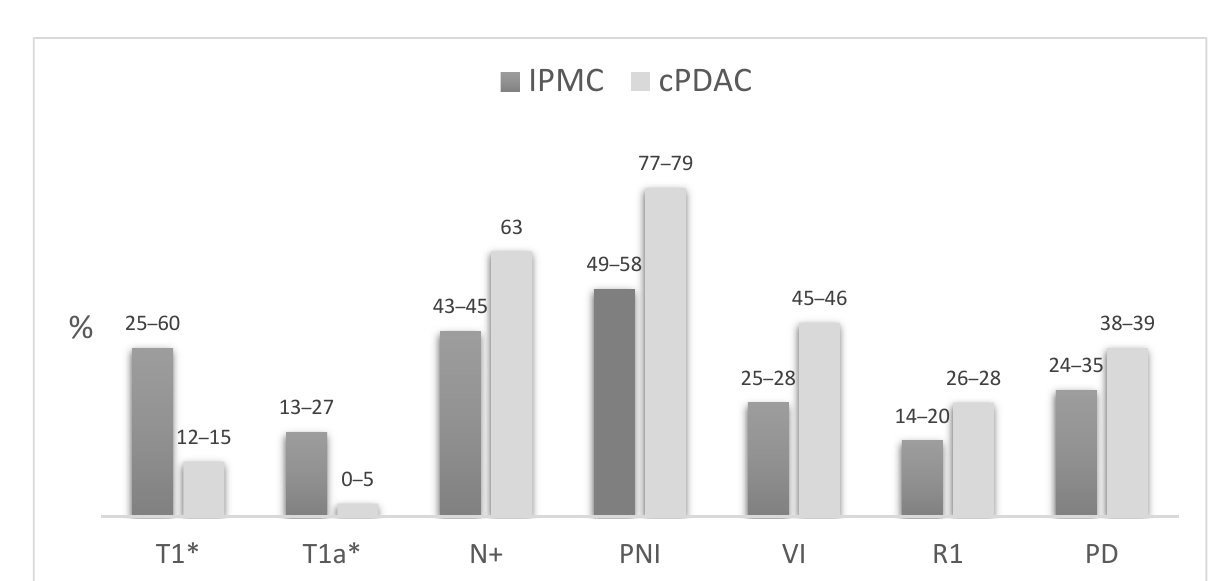
Figure 2. Comparison of pathological features of IPMC and cPDAC. Pooled data from Koh et al. [36] and Aronsson et al. [43]. * AJCC TNM 8th edition; PNI: perineural invasion; VI: vascular invasion; R1: resection margin positive for invasive carcinoma; PD: poor differentiation.